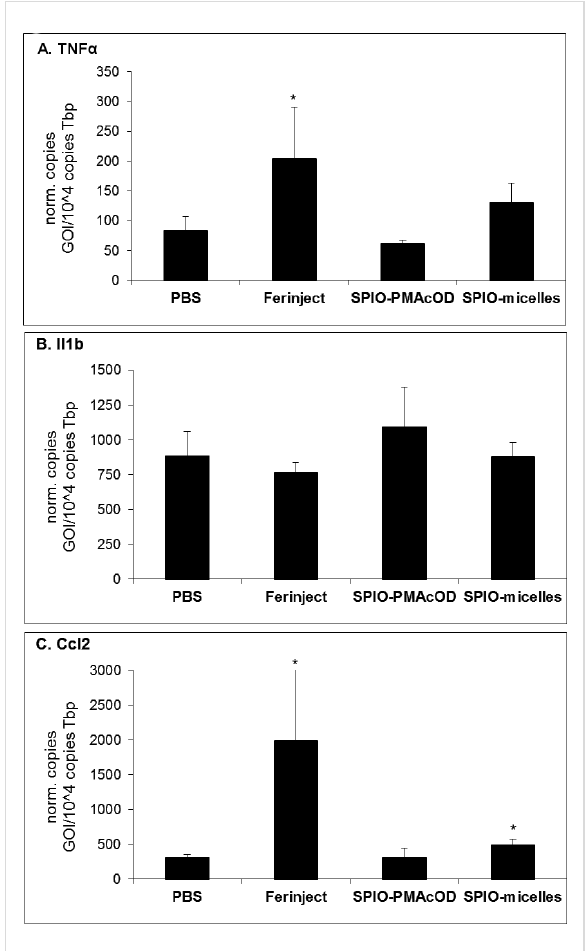
Figure 3: Impact of internalized SPIOs on gene expression. Wild type BALB/c mice were intravenously injected with PBS (iron free control), Ferinject ® (4.6 mg iron per mouse); polymer-coated SPIOs (100 µg iron per mouse) and SPIOs-micelles (50 µg iron per mouse). Gene expression analysis was performed for (A) TNF α , (B) Il1b and (C) Ccl2. The injection of high iron doses by using Ferinject ® but not the injec- tion of SPIOs increased the expression of pro-inflammatory TNF α and Ccl2. Mean values +/ − s.d. with n ≥ 4, * p <